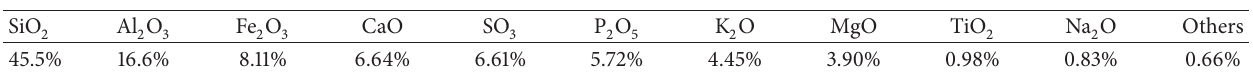
Table 4: The chemical properties of SSA.